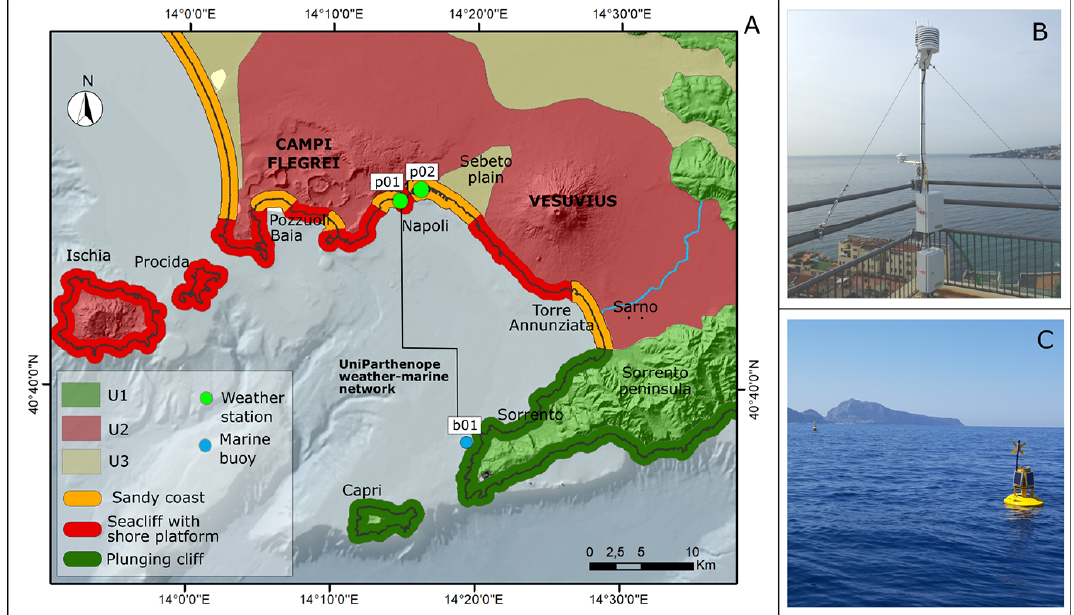
Figure 1. (a) Geological and geomorphological sketch of the study area. U1: limestones, dolomites, and marls of carbonate platform units (Meso-Cenozoic); U2: volcanoclastic deposits (Quaternary); U3: alluvial, coastal, palustrine-lacustrine, and slope deposits (Quaternary). The digital terrain model (DTM) of the emerged area was downloaded from ISPRA webGIS (http://www.sinanet.isprambiente.it, last access: 1 February 2021); the DTM of the emerged area was downloaded from the GEBCO website (http://www.gebco.net, last access: 1 Febru- ary 2021). Photos of the (b) weather station and (c) ondameter belong to the Parthenope University network.